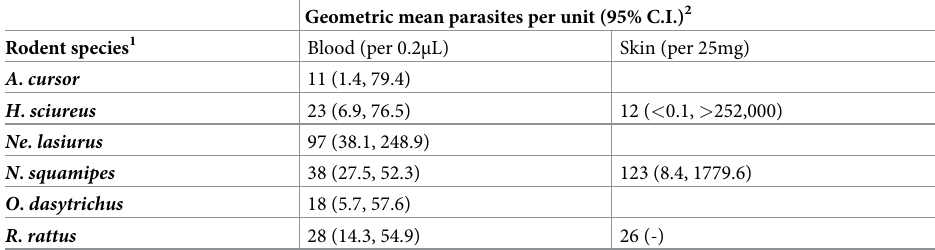
Table 3. Geometric number of L . (V) . braziliensis parasites in rodent clinical samples estimated by